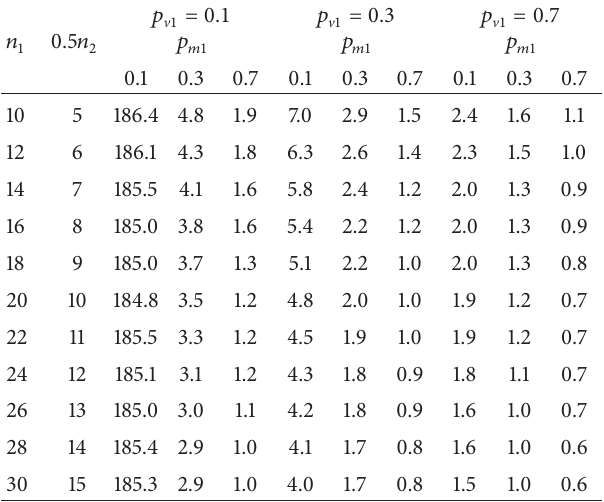
Table 11: The ARL 1 of the EWMA-AM and EWMA-AV charts for 𝜆